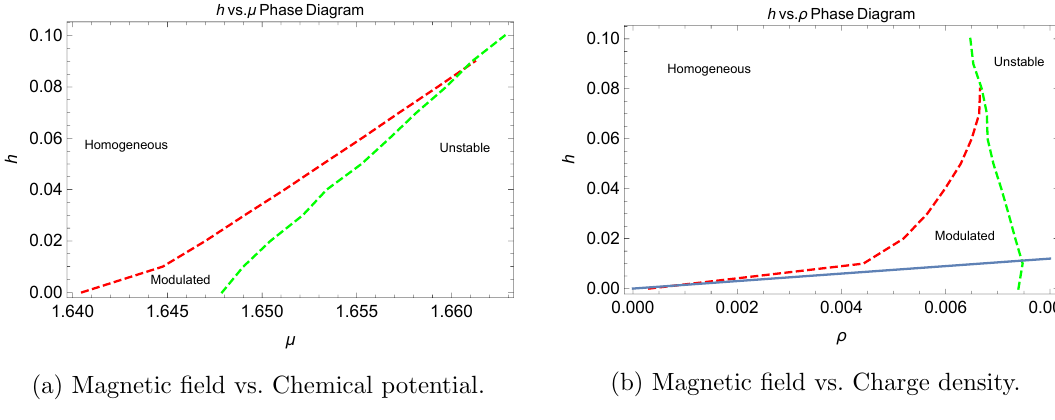
(b) Magnetic (cid:12)eld vs. Charge density. Figure 6 . Phase